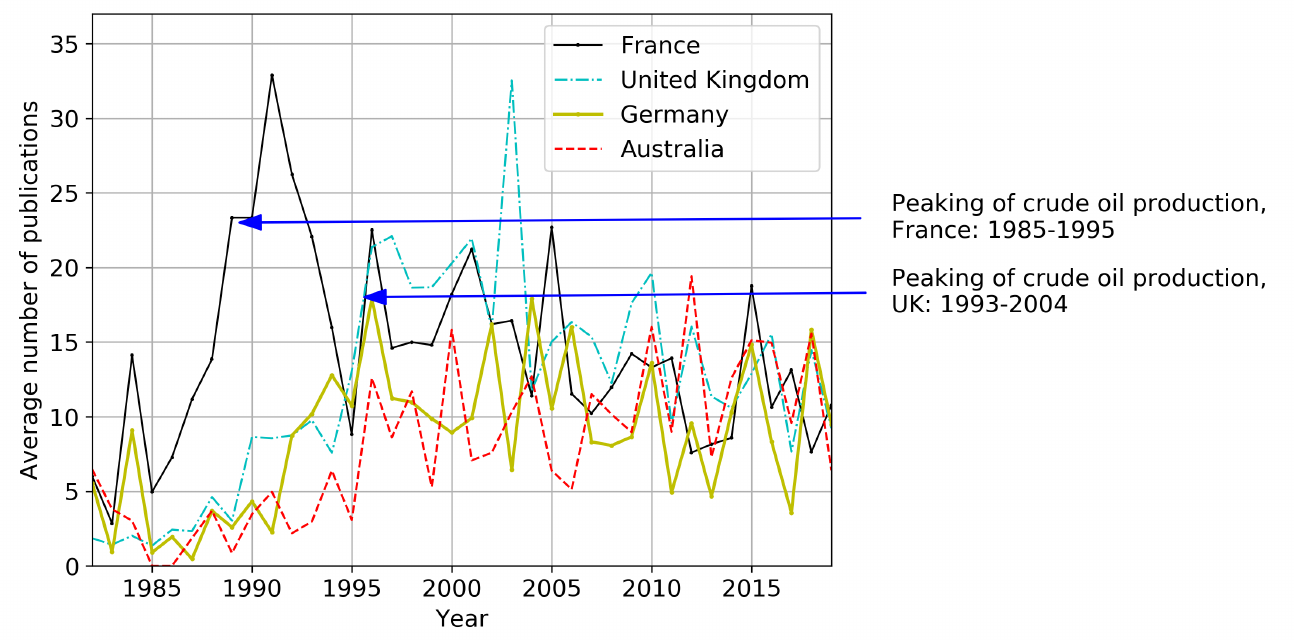
Figure 7. Average number of publications by France, UK, Germany, and Australia. Crude oil production data are from ref.